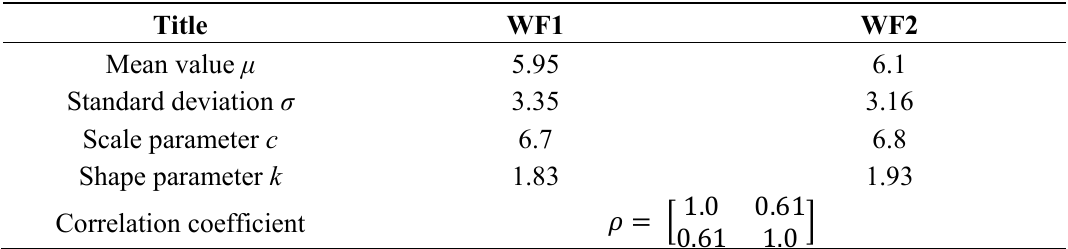
Table 2. Results for correlated Weibull distributions at peak